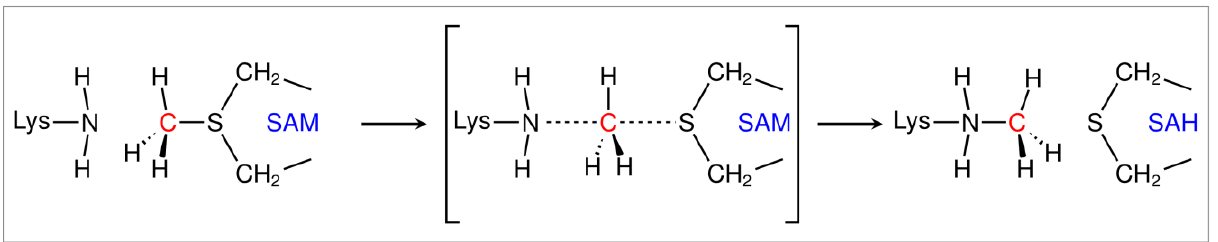
Figure 1. The reaction scheme of methyl transfer in PRDM9.